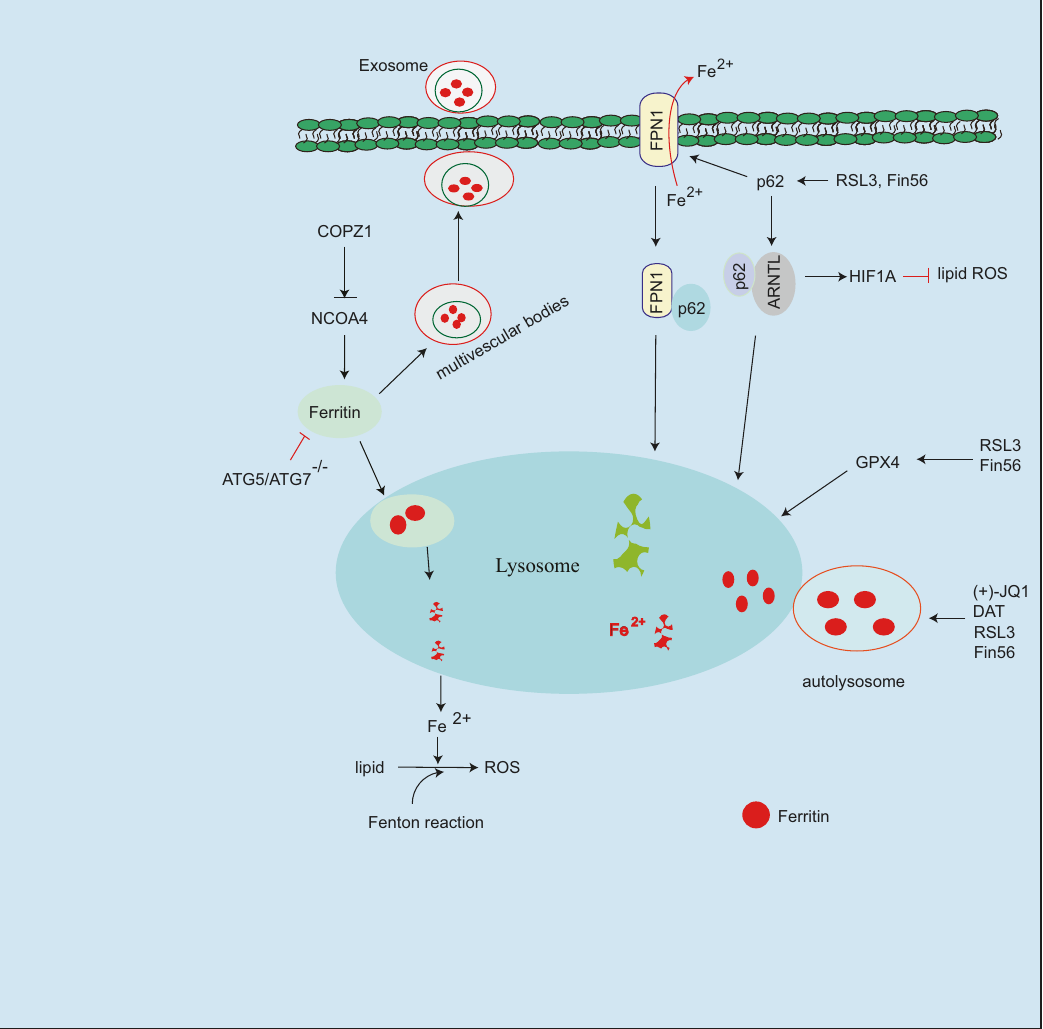
Fig. 3 Regulation of autophagy on ferroptosis. NCOA4 induces ferritin autophagic degradation leading to the release of iron, which in turn facilitates ferroptosis, while COPZ1 inhibits NCOA4/ferritin pathway. Ferritin could be embedded into multivesicular bodies and traf fi c out of cells as exosome leading to reduced intracellular iron levels and ferroptosis resistance. In response to inducers, p62-mediated FPN1 or ARNTL autophagic degradation, which in turn promote sensitivity of ferroptosis. Although ferritinophagy is triggered in response to inducers including RSL3, Fin56, DAT etc, the mechanism is